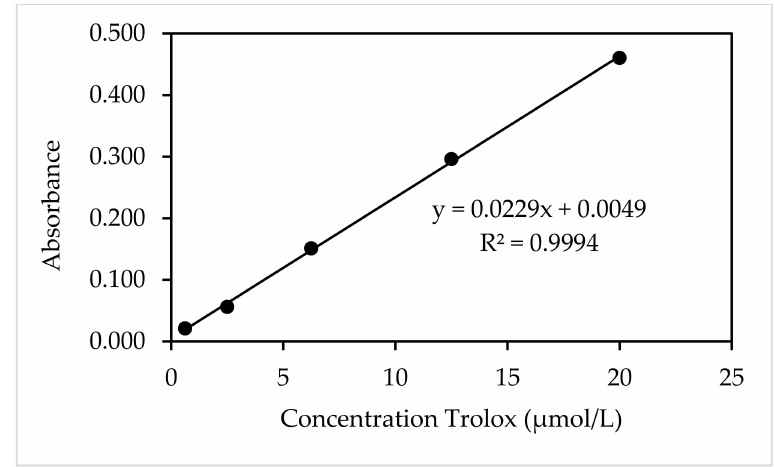
Figure A4. Calibration curve for antioxidant activity